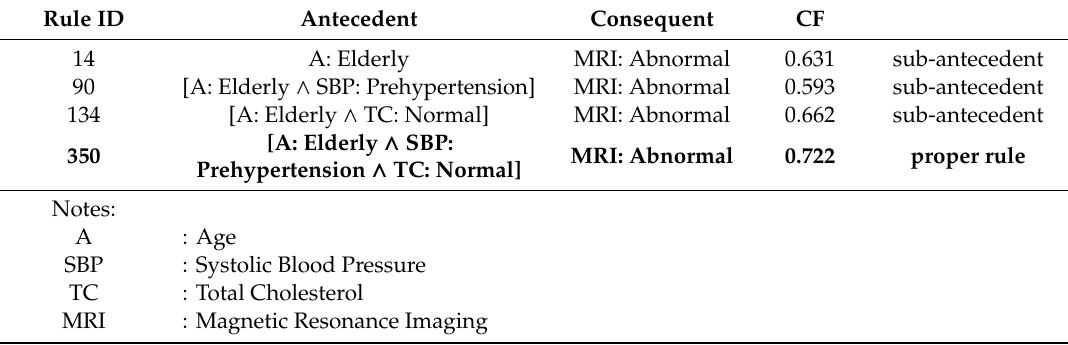
Table 4. Example of subsumption rules (proper rule and its sub-antecedents)